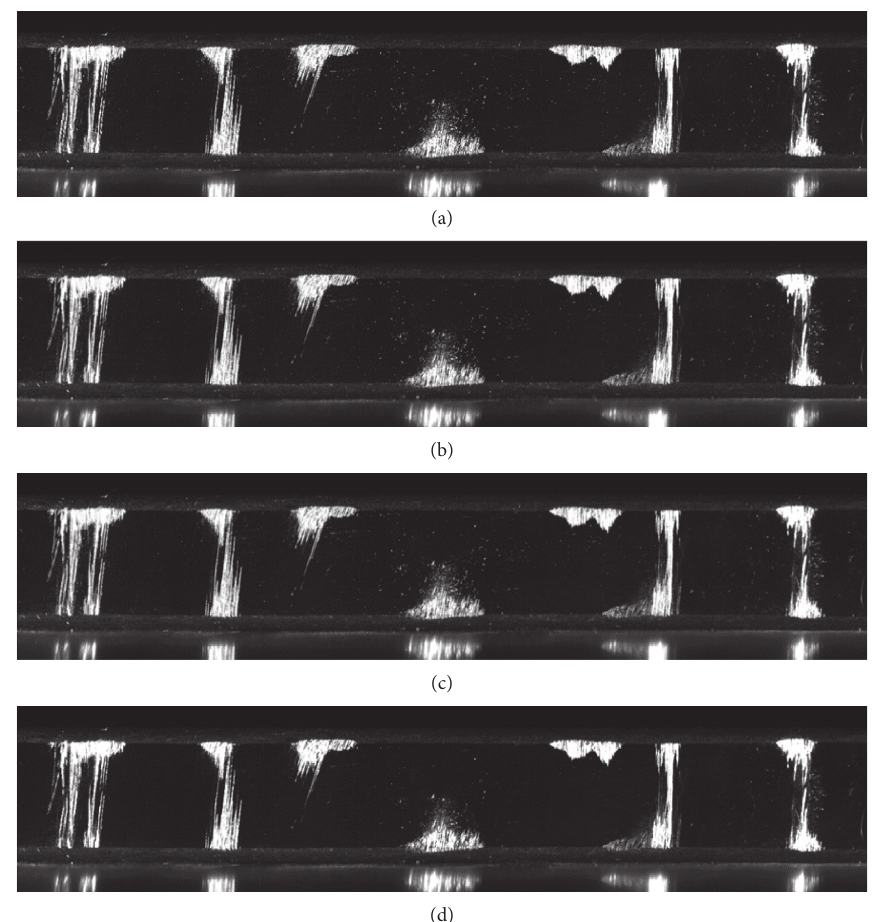
Figure 3: Performance comparison of three filter algorithms: (a) original image; (b) Gaussian filter with σ � 1.55; (c) mean filter; and (d) median filter.